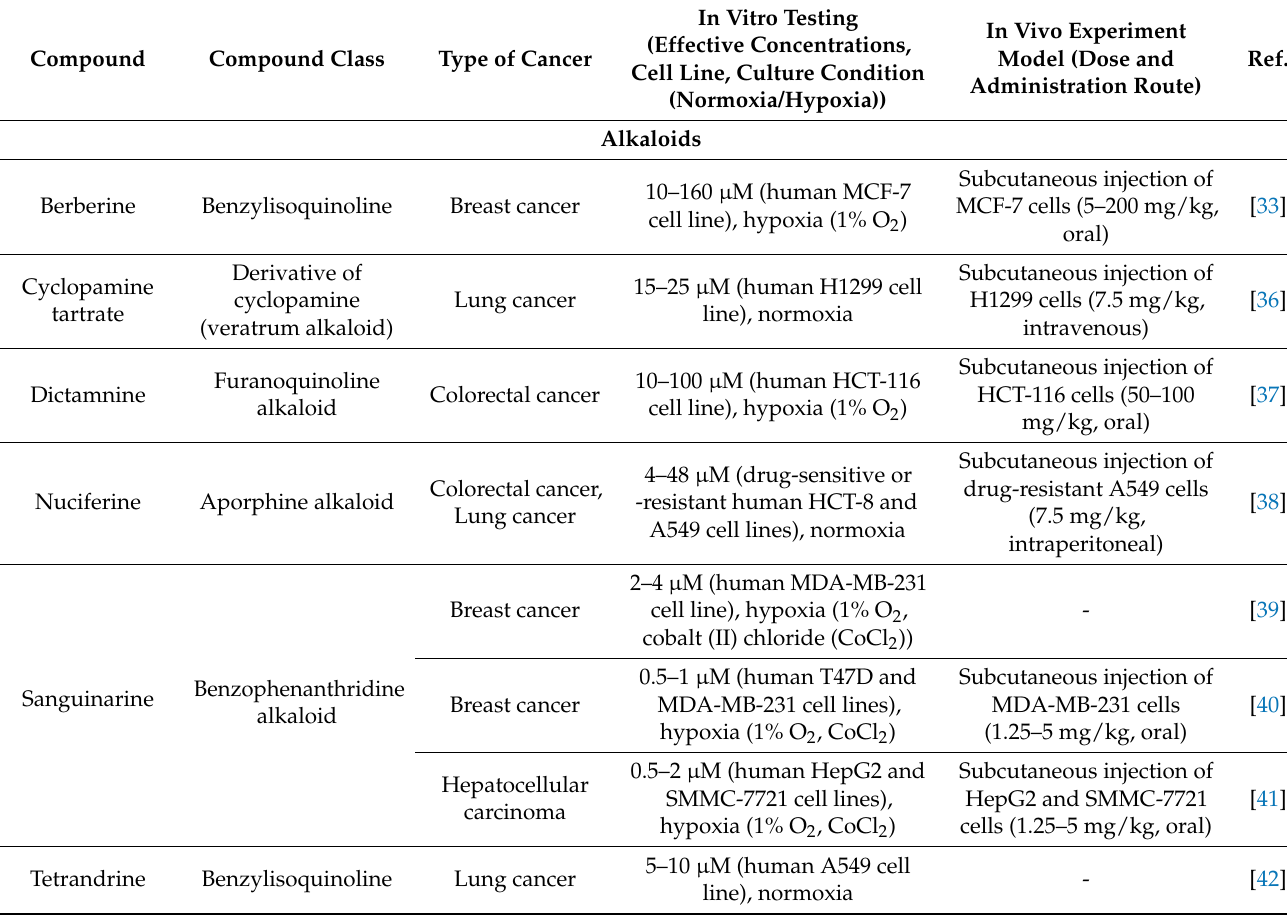
Figure 1. Proposed signaling pathways of HIF-1 α regulation by alkaloids and organosulfurs. Positive regulation is indicated by arrow lines (blue). A negative effect is shown by perpendicular lines (red). Table 1. The list of alkaloid and organosulfur compounds that suppress HIF-1 α in cancer (alphabetical